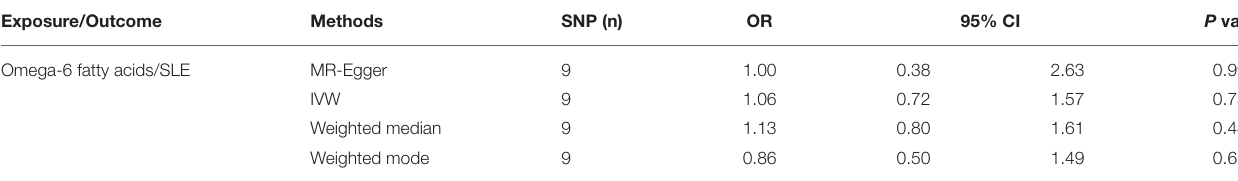
TABLE 2 | Causal effects of Omega-6 on the risk for